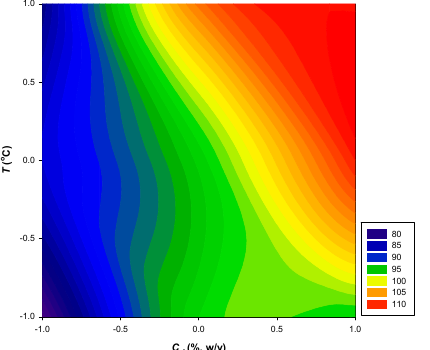
Figure 1. Contour plots illustrating the effect of the independent variables considered on the Y TP . The upper left, upper right and lower plots show the effect of simultaneous variation of C gl and C CD , T and C CD and T and C gl , respectively (numbers on the axes correspond to coded values). Extractions of oak acorn husks were carried out under stirring at 600 rpm, for 180 min and a liquid-to-solid ratio of 50 mL·g − 1 .